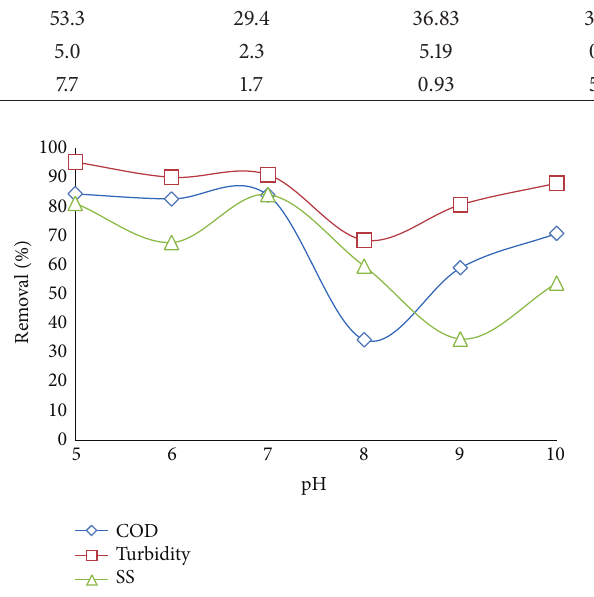
Figure 3: Effect of spent coolant wastewater pH on banana stem juice coagulant